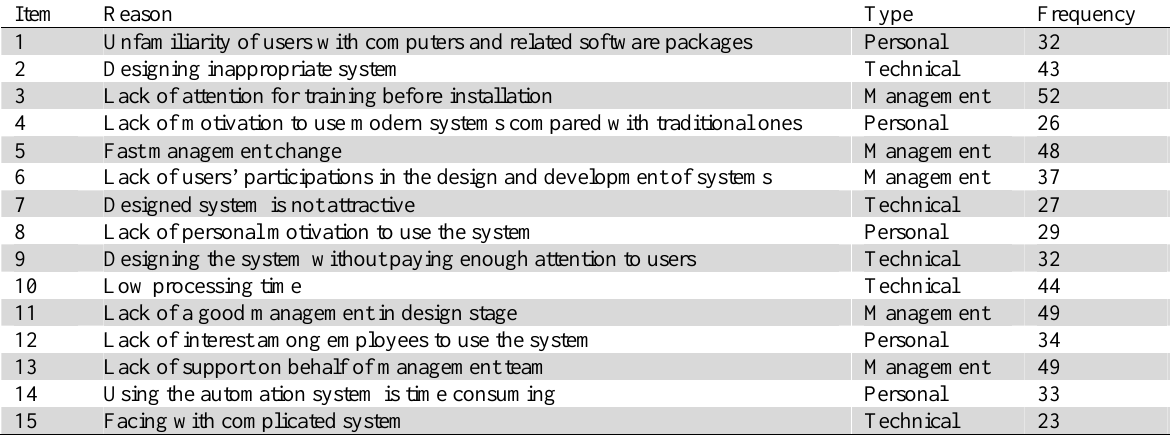
The summary of different barriers for having efficient office